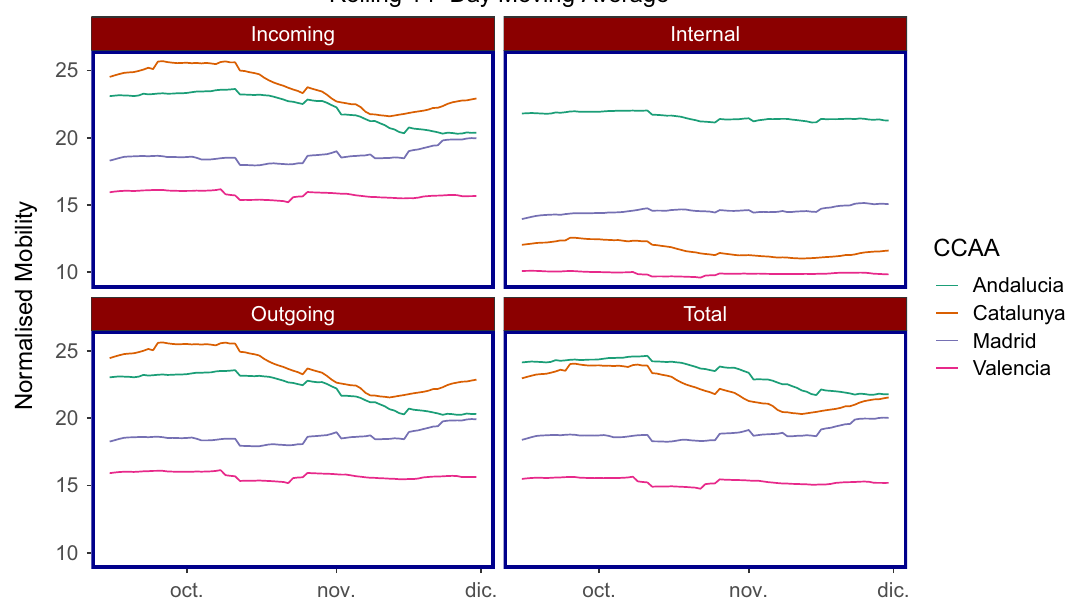
Figure 12. 14-Day rolling average for different mobility types. Only the top 4 CCAA’s are reported for ease of composition. It is evident that after the policy, Cataluña’s mobility dropped significantly for incoming , outgoing and total and began increasing once the restrictions on bars and restaurants eased. The same can not be said for the internal mobility type. On the x-axis, dic refers to Diciembre (December).